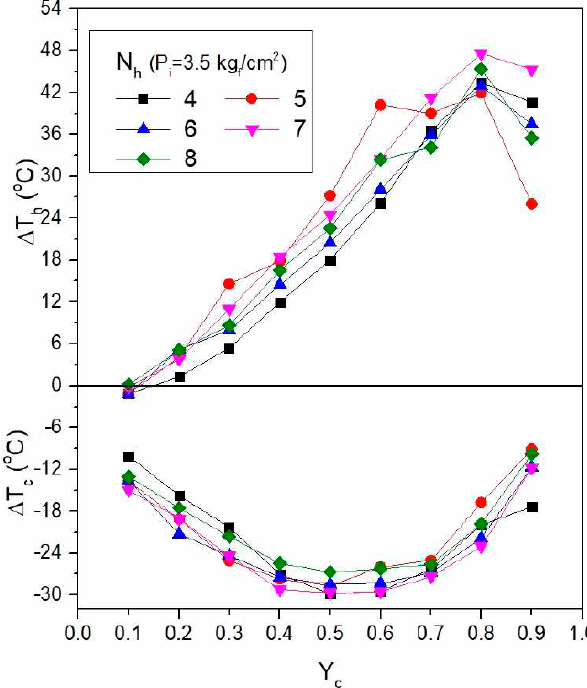
Figure 17. Temperature differences ∆ T h and ∆ T c according to inlet pressure (P i ) 3.5 kgf/cm 2 .